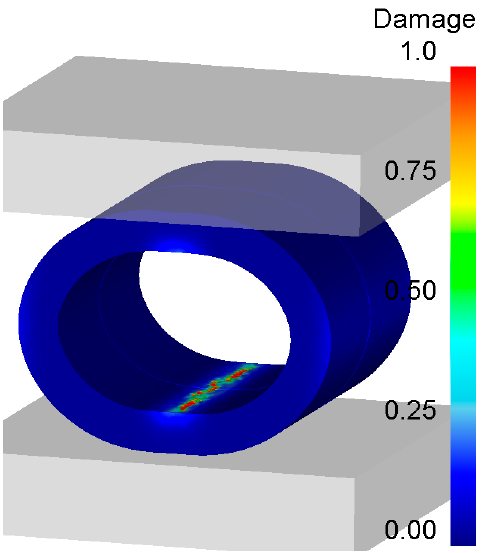
Figure 33. Simulation model of axial compression of an unnotched ring.